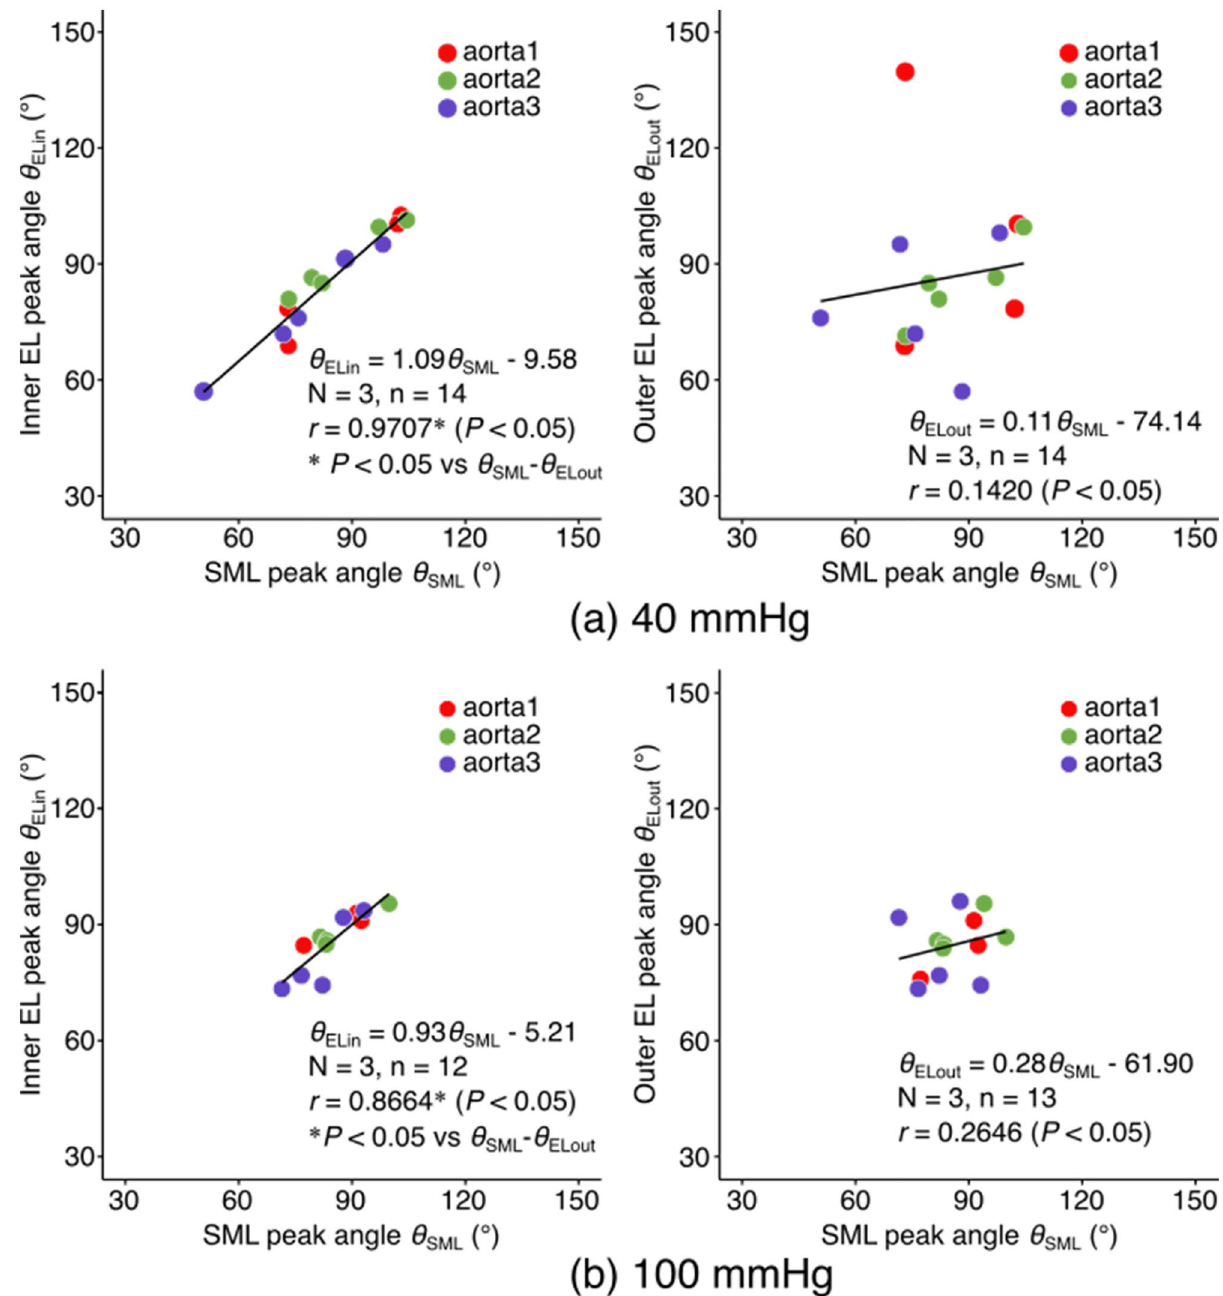
Figure 7. Correlation analysis of EL peak angles and SML peak angles. The correlation was calculated between SML and its inner EL (left) and between SML and its outer EL (right). The angles were obtained at the pressure level of ( a ) 40 mmHg and ( b ) 100 mmHg, respectively. The peak angle at 90° corresponds to the circumferential direction of the aorta. N, number of specimens; n, the total number of the pairs of SML and EL layers analyzed. Statistical analysis was performed for